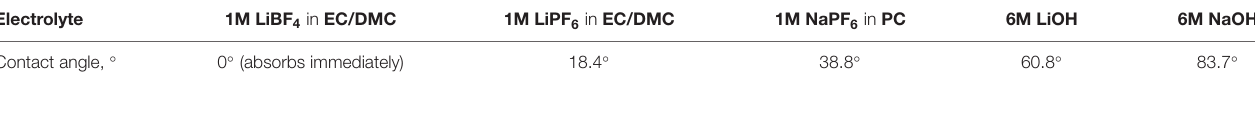
TABLE 1 | Contact angles of the carbon electrodes in aqueous and non-aqueous lithium and sodium electrolytes. Electrolyte Contact angle,